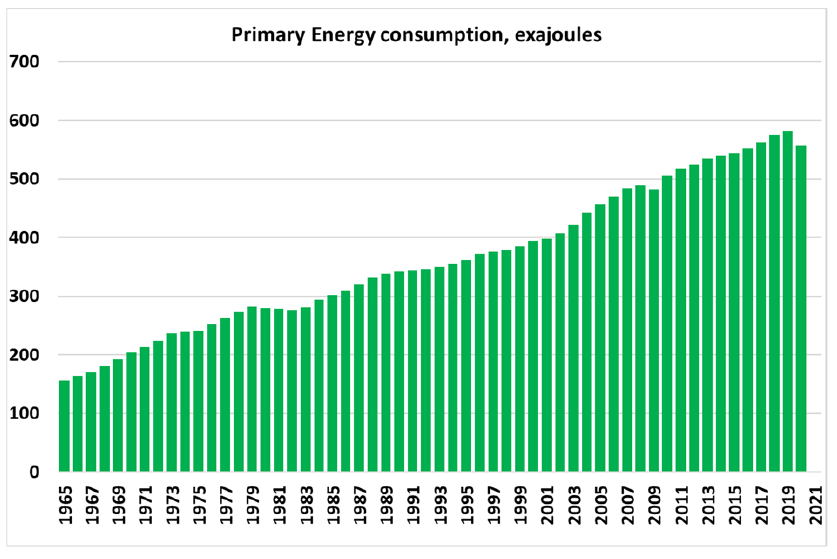
Figure 1. Primary Energy consumption, exajoules [5].